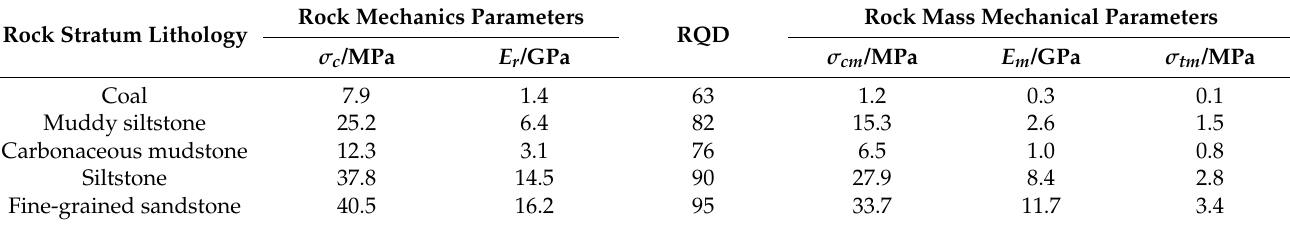
Table 1. Conversion of rock parameters and rock mass parameters.